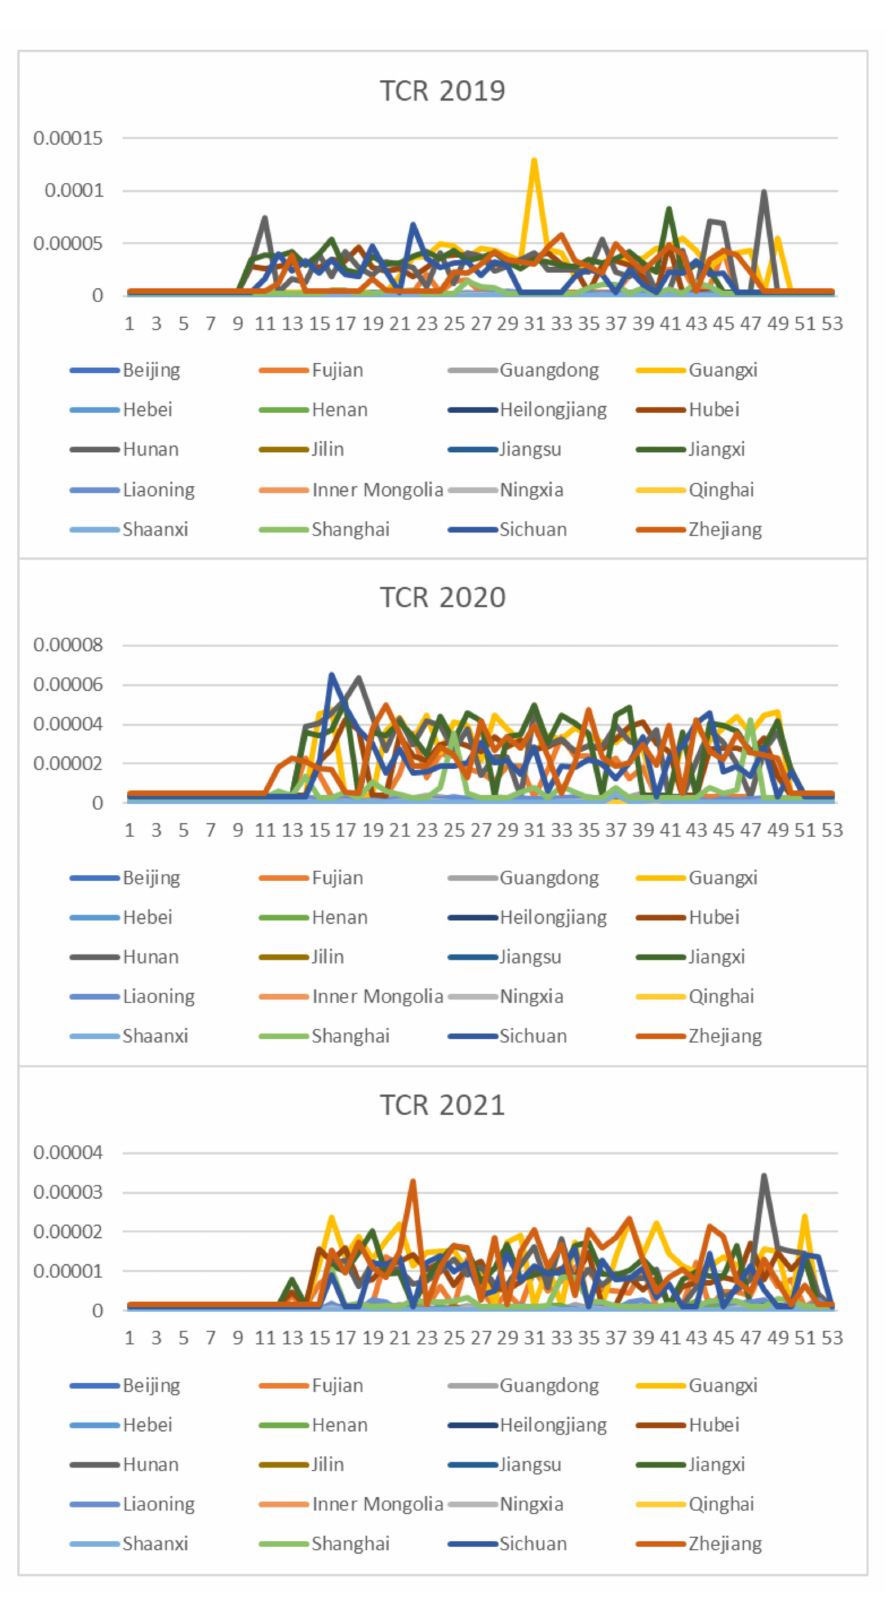
Figure 6. Dataset of rice safety risk assessment indicator